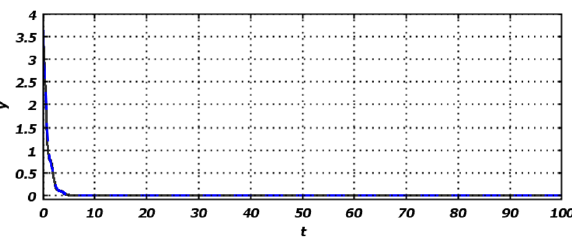
Fig. 5 Exponential decay: y = E ( t ) e 0 . 1